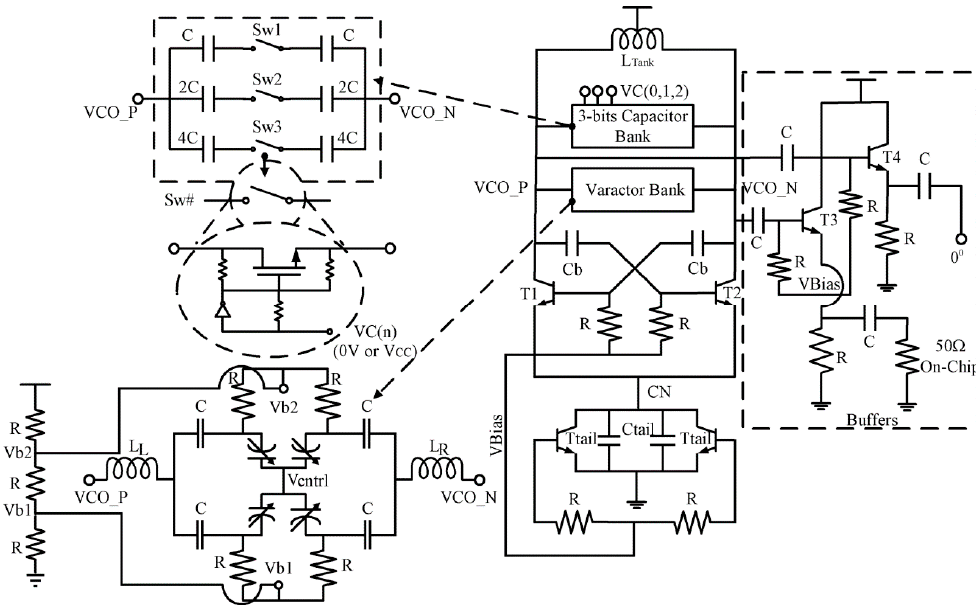
Figure 7. Complete schematic of a Differential Voltage Controlled Oscillator (DVCO) incorporated with proposed wideband varactor circuit.